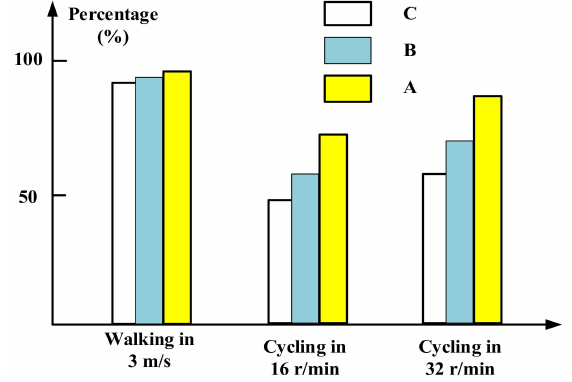
Figure 9. Frequency of activated EMG values during tests (Table